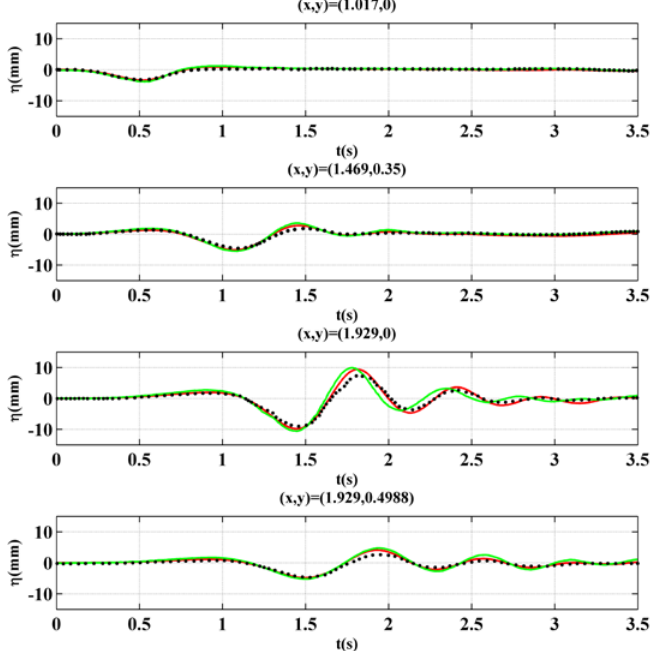
Figure 12. Comparison of present results (red line) with experimental data [6] (black dots) and the results in Fuhrman and Madsen [10] (green line) in case 3.